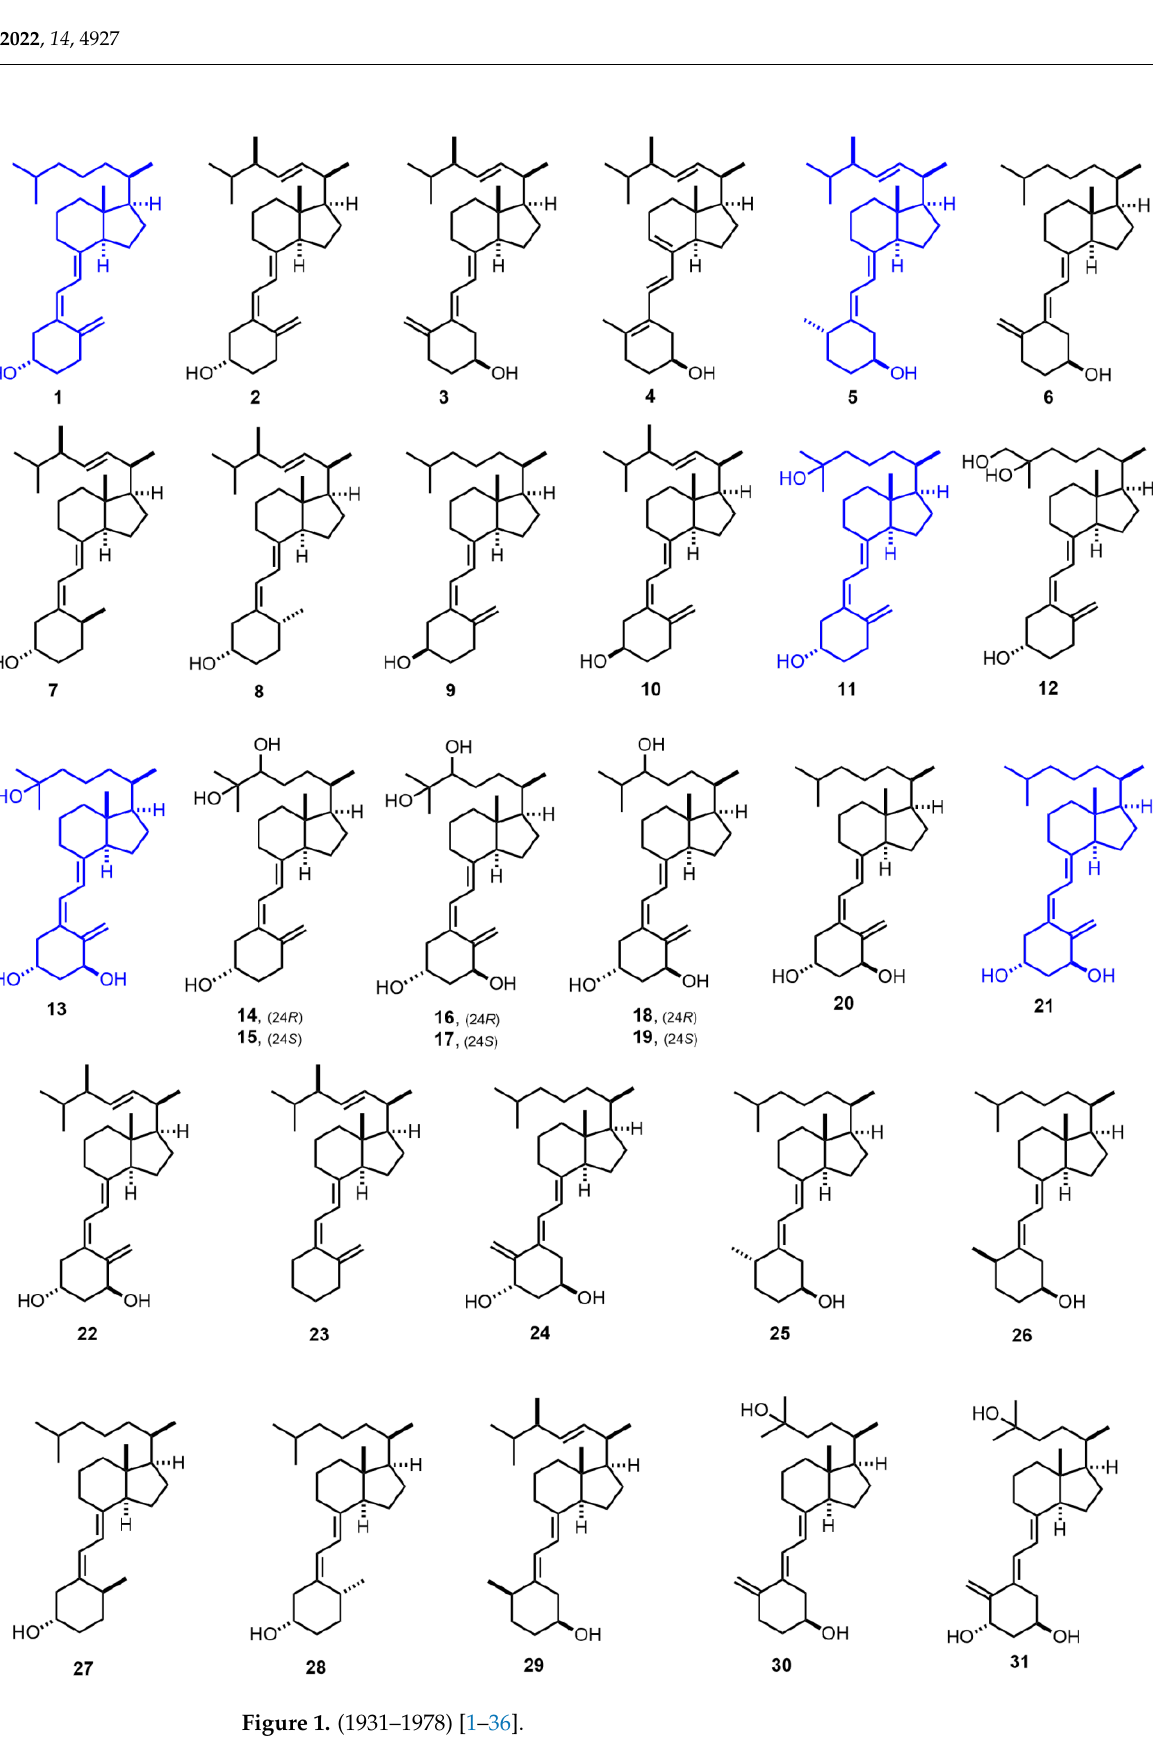
Figure 1. (1931-1978) [1 – 36].